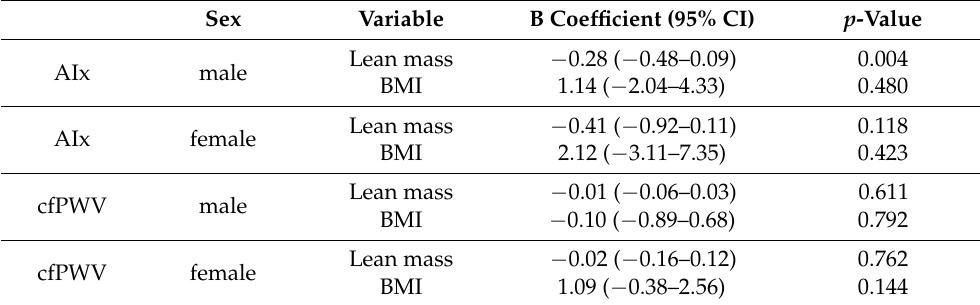
Table 4. Regression analysis for arterial stiffness and lean mass according to